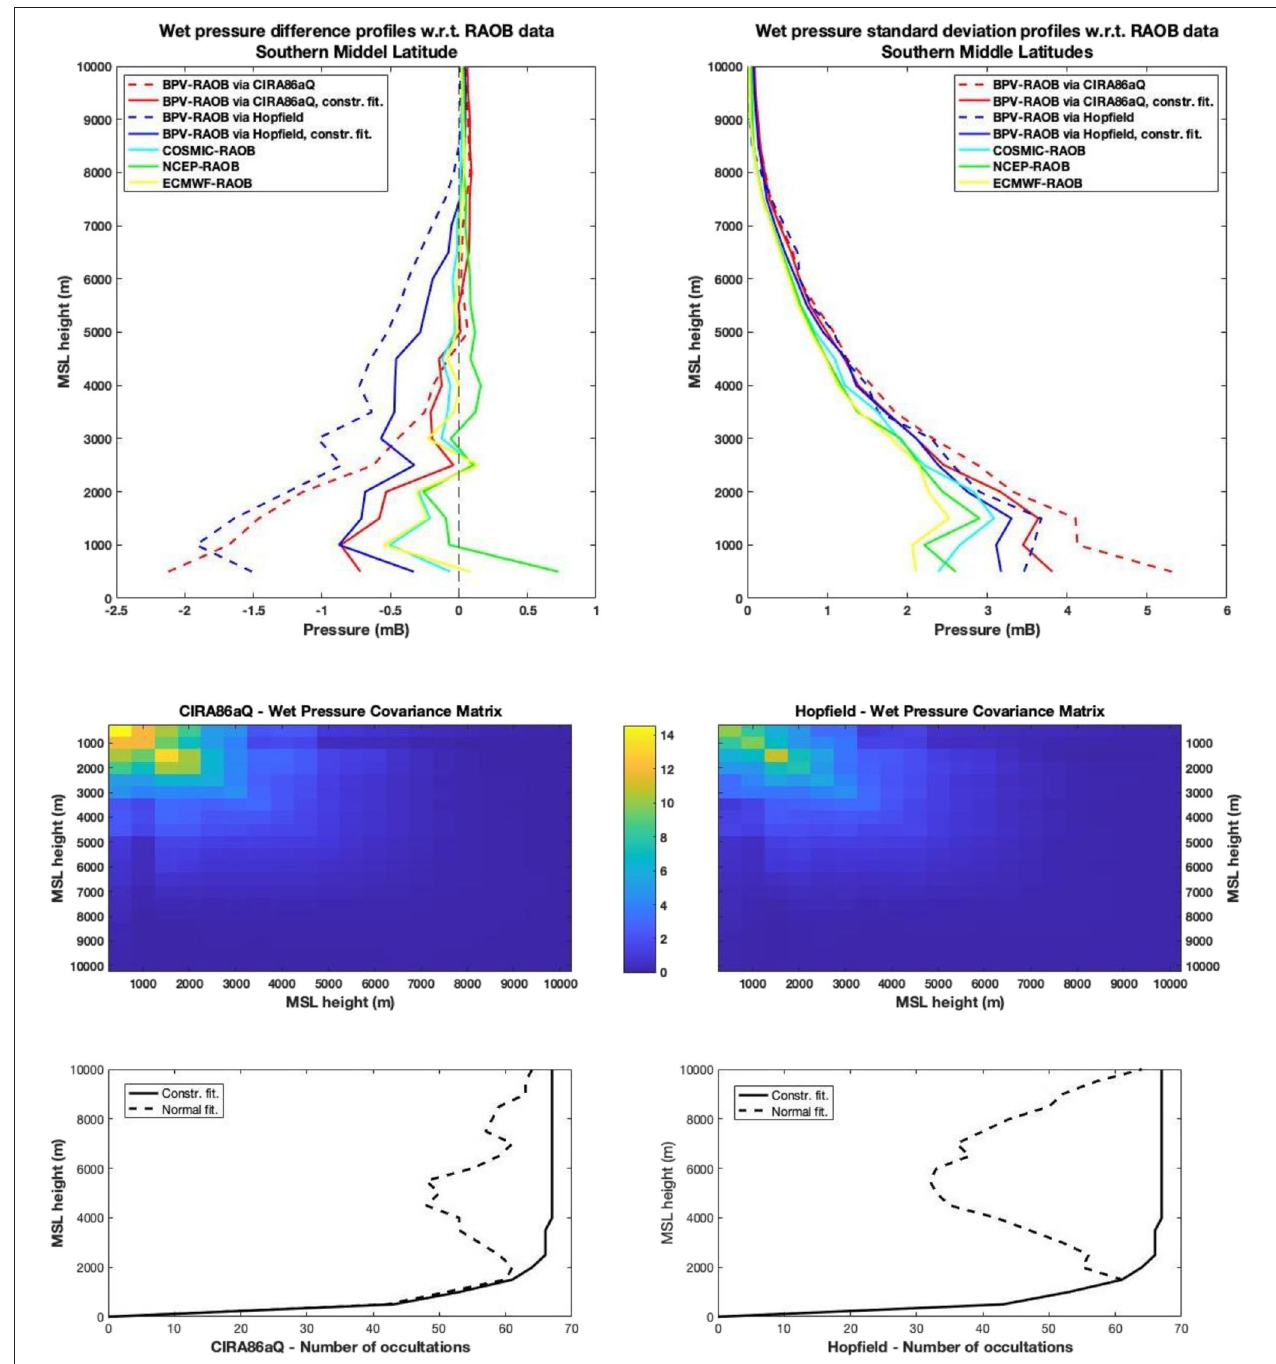
FIGURE 9 | Top: Difference (left) and standard deviation (right) profiles for the wet pressure data at Southern Middle Latitudes, with respect to the RAOB values. Middle: Covariance error matrices for the constrained CIRA86aQ case (left) and the constrained Hopfield case (right). Bottom: Number of RO observations considered, in both the constrained and unconstrained case, for the CIRA86aQ (left), and the Hopfield (right).